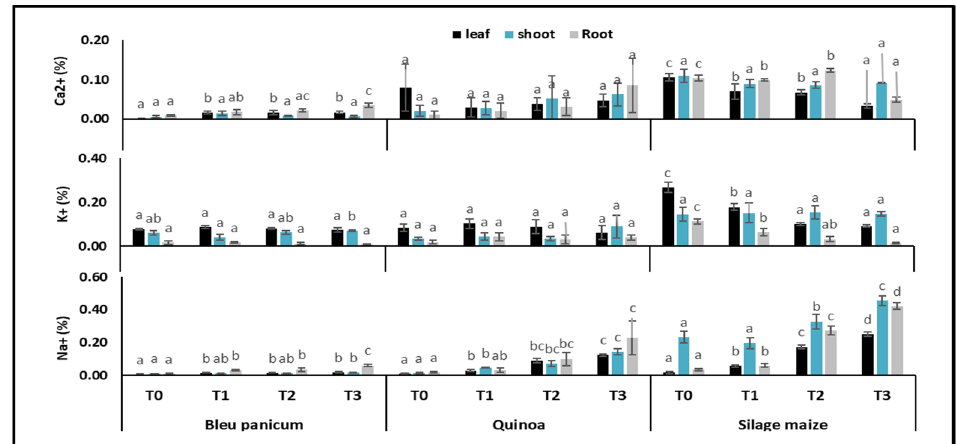
Figure 1. Mean content of calcium Ca 2+ (%), potassium K + (%) and sodium Na + (%) in the leaves, stems, and roots of blue panicum, quinoa and silage maize for each treatment. The symbols T0 (0.9 dS m − 1 ), T1 (3 dS m − 1 ), T2 (6 dS m − 1 ), and T3 (10 dS m − 1 ) refer to the four saline irrigation water treatments. Lower-case (a, b, c, d) show differences between treatments for leaf, shoot and root within each tested plant species. Columns with the same letter over them are not significantly different ( p < 0.05) (Mean ± standard deviation; n = 3).